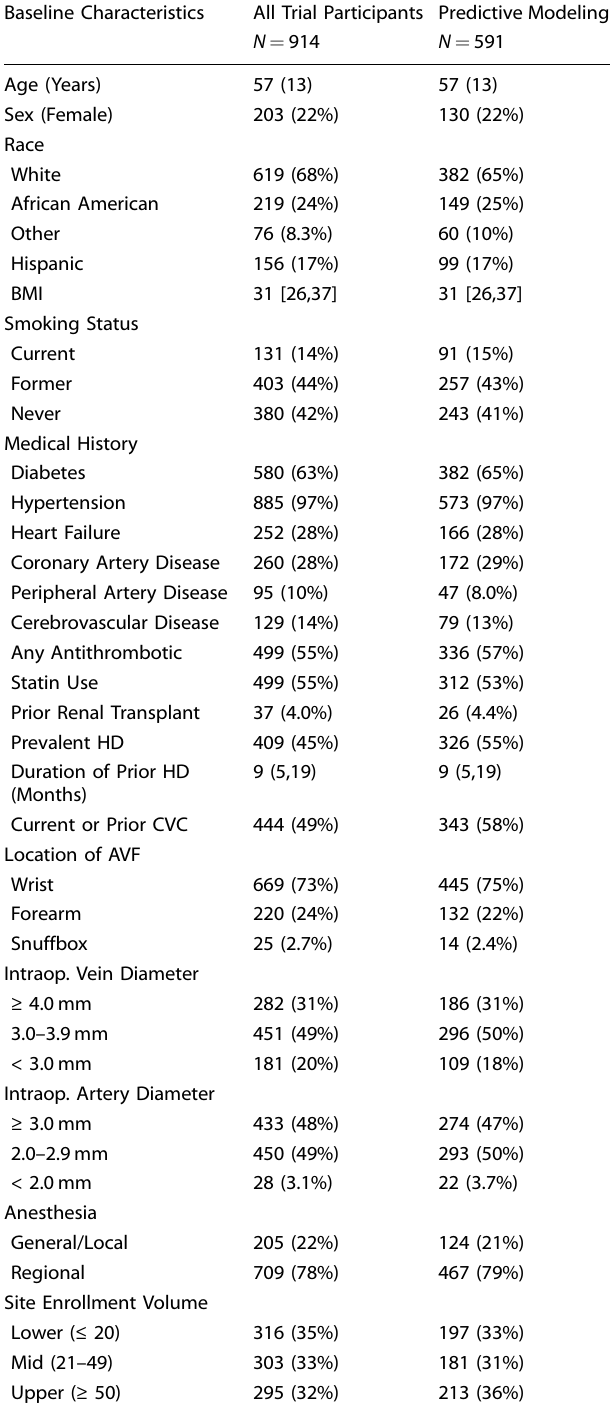
Table 1. Characteristics of all trial participants and prediction model- building